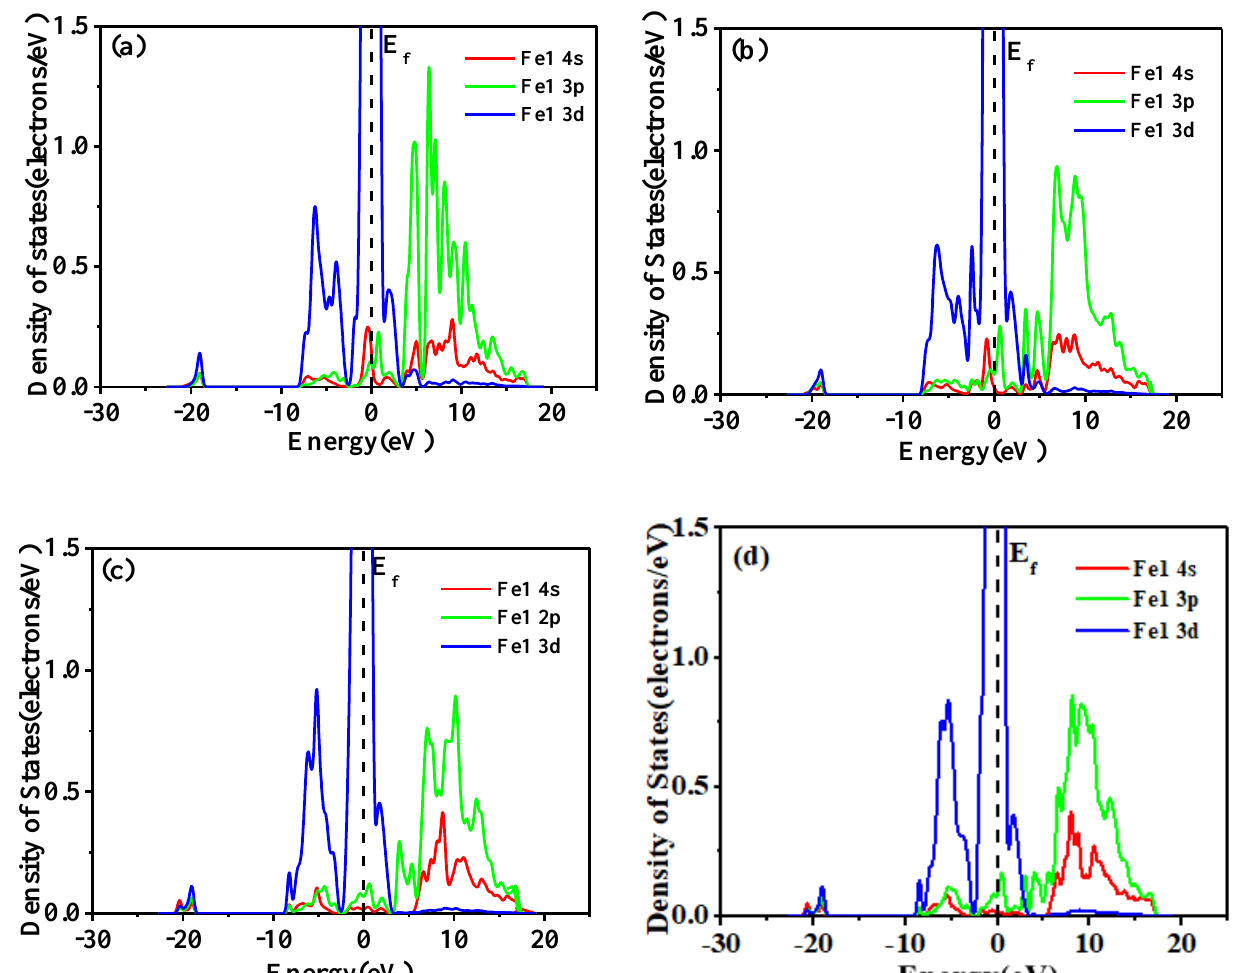
Figure 3. PDOS of Fe1 atom on the surface of different adsorption models. ( a ) Initial configuration, ( b ) after Cu 2+ adsorption, ( c ) after Cu(OH) + adsorption, and ( d ) after Cu(OH) 2 adsorption.